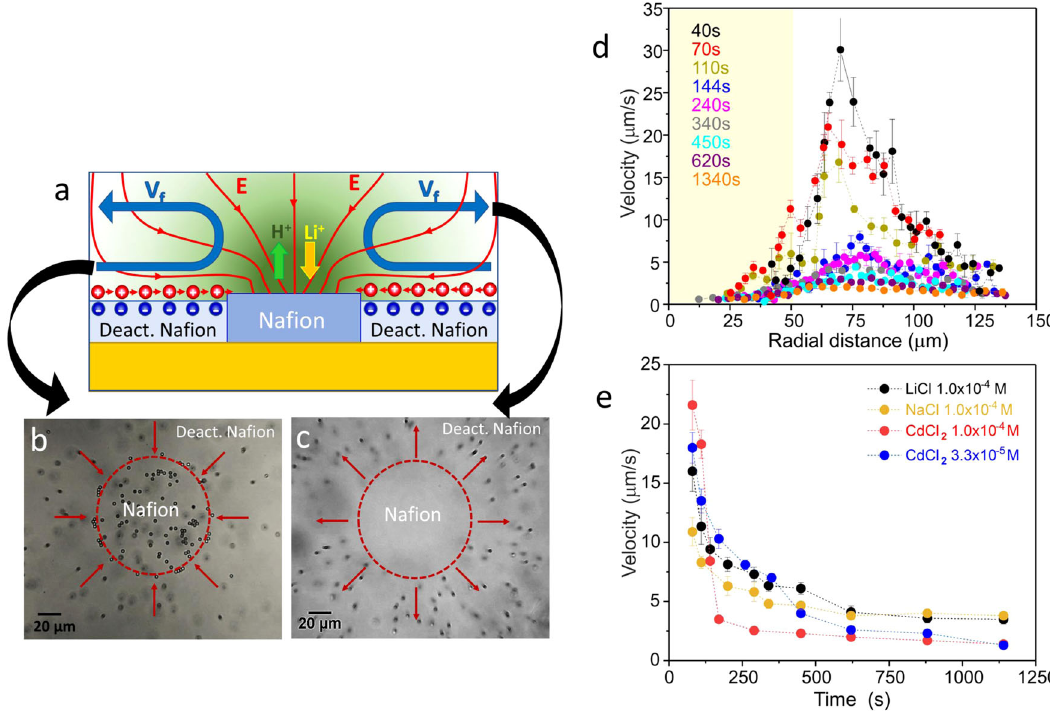
Fig. 1 Radial Na fi on micropumps. a (top) Schematic picture of the cross section of a Na fi on micropump, illustrating the pumping mechanism. The ion- exchange generates an ion concentration gradient (in green) and an electric fi eld ( E ) schematized by the red lines, mimicking those obtained from the simulations as described in the Supplementary Figure 3. The charges in the deactivated Na fi on illustrate the negative zeta potential of this surface (negative charges at the active Na fi on interface are not shown for simplicity). The positive charges in the liquid interface denote the counterions that will be moved by the tangential component of the ion-exchange self-generated electric fi eld, dragging a fl uid fl ow ( V f ) towards the active Na fi on disc. Near the disc edge, the fl ow goes up by fl uid continuity and fi nally bends outwards due to the presence of the top wall. b , c Top view snapshots of the actual Na fi on pump taken at different heights above the surface. The polystyrene tracers dragged by the fl uid approach the Na fi on structure as shown in the image captured at a plane near the surface b and then they are lifted by the fl uid and move away from the Na fi on patch, as shown by the image taken at a z -plane located at 100 µ m from the surface c . d Average radial velocity of polystyrene tracers dispersed in 1.0 × 10 − 4 M of LiCl near the surface as a function of the radial distance and at different pumping times. Data of the different curves have been obtained by evaluating and averaging the trajectory of more than 50 polystyrene particles. The yellowish shaded area represents the presence of the Na fi on disc from the center of the disc (0 µ m) to the edge (50 µ m). e Time evolution of the maximum radial velocity of tracers averaged over 25 – 50 trajectories in presence of aqueous solutions containing different salt cations. Error bars in the fi gures represent the standard deviation. Source data of d , e are provided as a Source Data fi